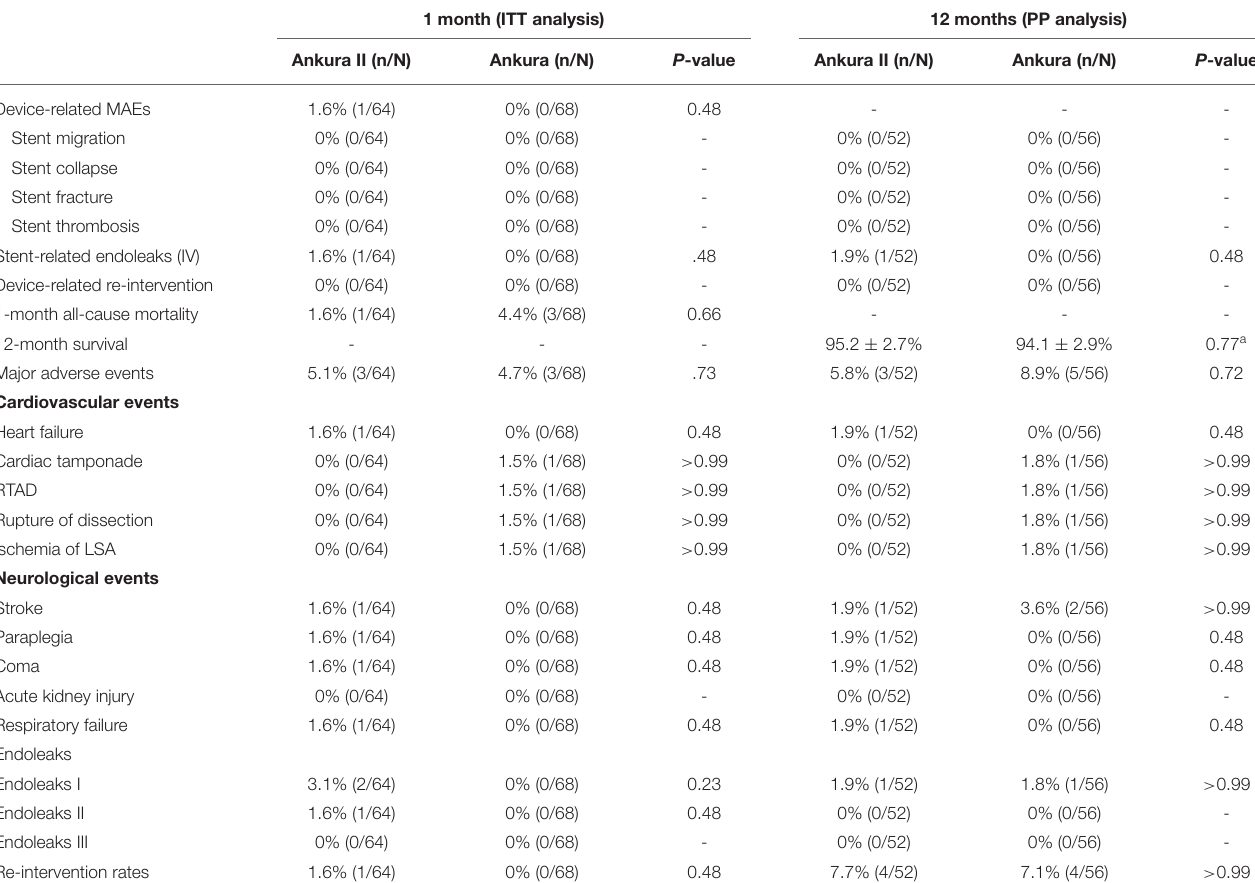
TABLE 3 | Device-related major adverse events, mortality, and major adverse events. 1 month (ITT analysis) 12 months (PP